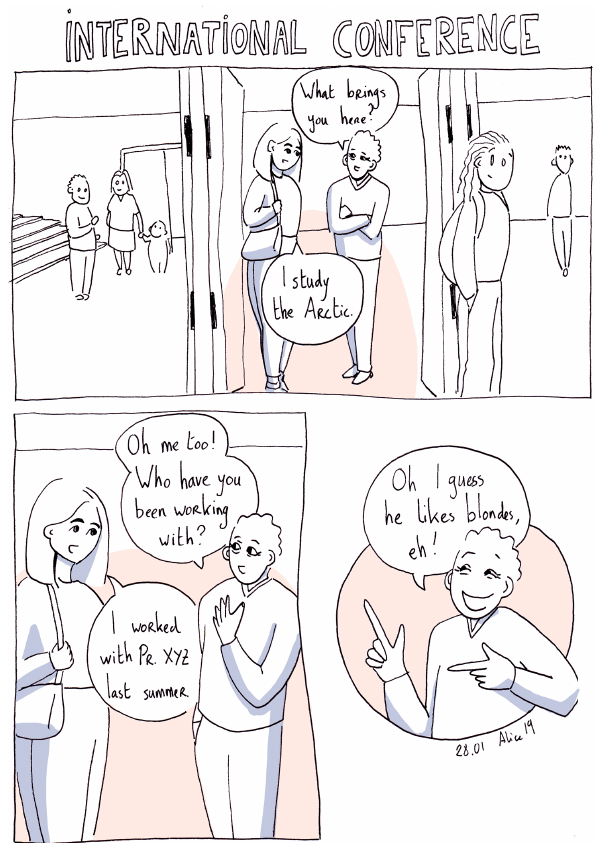
Figure 5. Example of the “Questioning female competence” cat- egory. A male colleague is putting the physical appearance of his female peer ahead of her qualification while playing down her scientific competence. Comic strip title: “Professor likes blondes” (DTRH team, 2019a; Adenis, 2019). All comics are hand-drawn by Alice Adenis – distributed under the Creative Commons Attribution 4.0